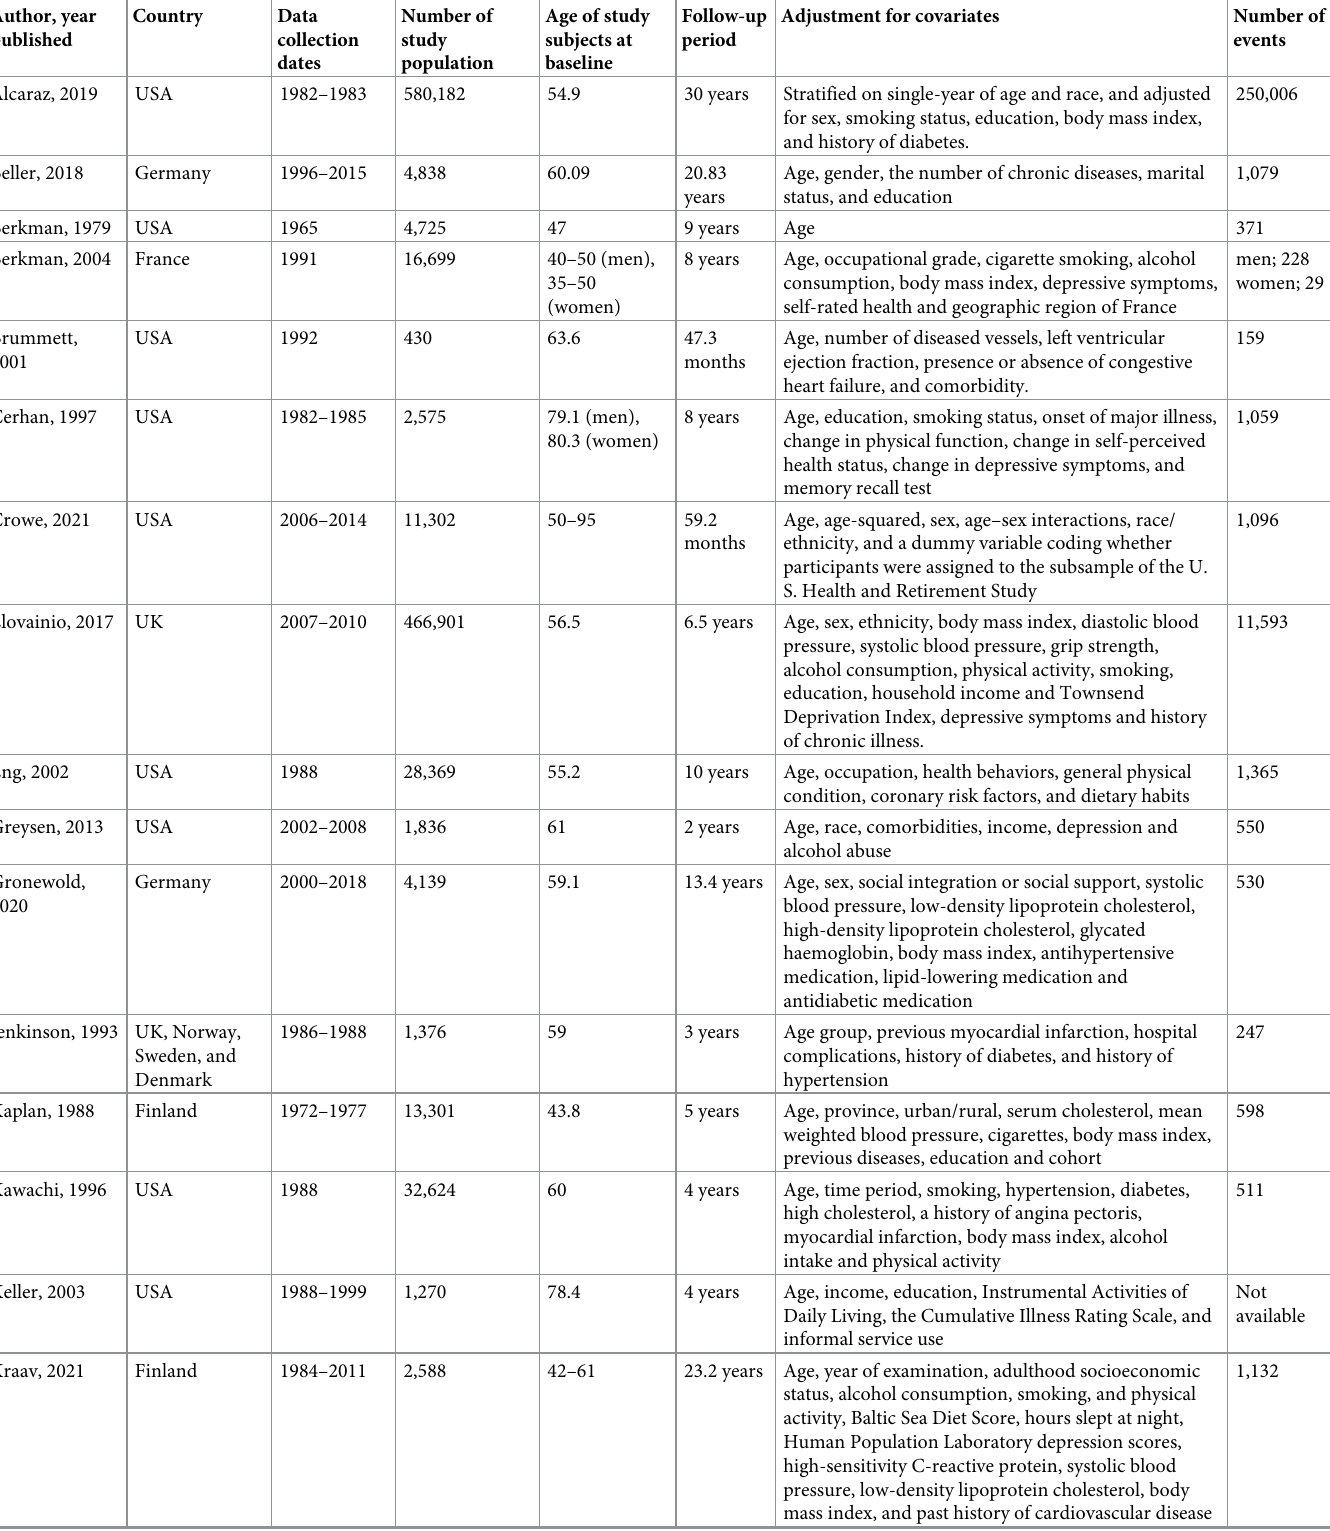
Table 1. Characteristics of 36 studies included in this systematic